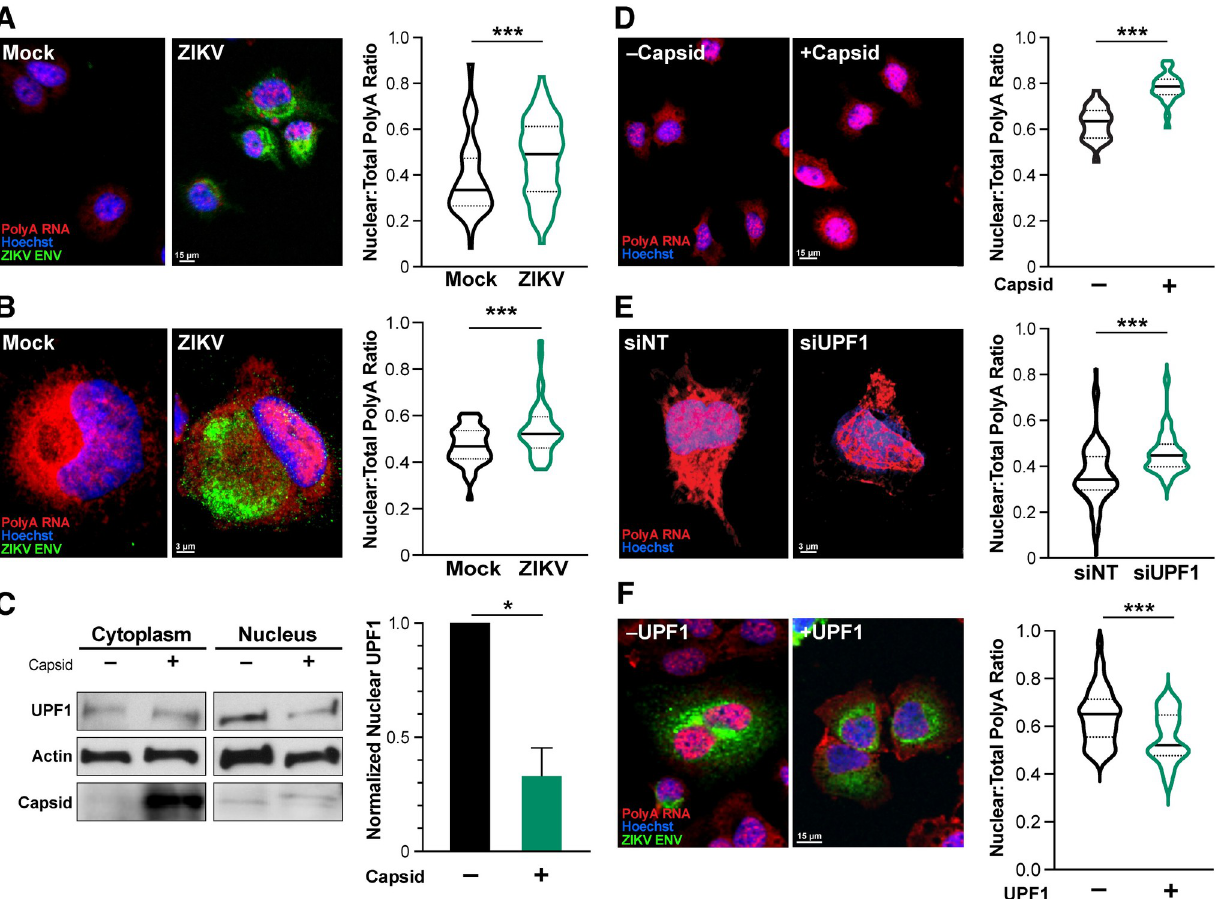
Fig 3. ZIKV-mediated degradation of UPF1 leads to mRNA retention in the nucleus. A and B) During ZIKV infection (ZIKV ENV, green), polyA RNA (red) is shifted toward the nucleus (Hoechst, blue) in Huh7-Lunet cells (A) and NPCs (B). Statistics produced by a Linear Mixed Model. 3 biological replicates, n = 25 cells (A) or 15 cells (B) per condition per replicate. C) Tetracycline-inducible Capsid expression in Huh7-Lunet cells was used to degrade nuclear UPF1. Leptomycin B (LMB) was used to increase UPF1 degradation. Statistics performed by Student’s t-test, n = 3, and representative western blot shown. D) Capsid overexpression in Huh7-Lunet cells results in an increased ratio of polyA RNAs (red) in the nucleus. N = 3 biological replicates, 25 cells per condition per replicate. E) Knockdown of UPF1 in NPCs results in an increased ratio of polyA RNAs (red) in the nucleus. NPCs were treated with siNT and siUPF1 for 96 hours. Statistics produced by a Linear Mixed Model. n = 3 biological replicates, 15 cells per condition per replicate. F) Tetracycline-inducible UPF1 expression in Huh7-Lunet cells was used in conjunction with ZIKV infection to prevent the polyA RNA shift to the nucleus. Statistics produced by a Linear Mixed Model. n = 3 biological replicates, 15 cells per condition per replicate. � , P � 0.05; �� , P � 0.01; ��� , P � 0.001. Error bars are SEM. Individual channels are shown in S5 Fig. Nuclear to cytoplasmic ratios are provided in S6 File.